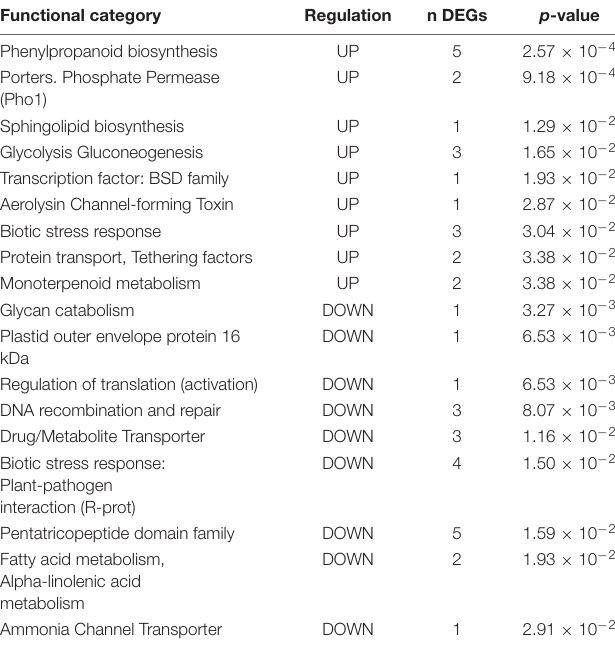
TABLE 2 | Functional enrichment in Group I. DEGs up- and down-regulated by the two pathogens (IPP). Functional category